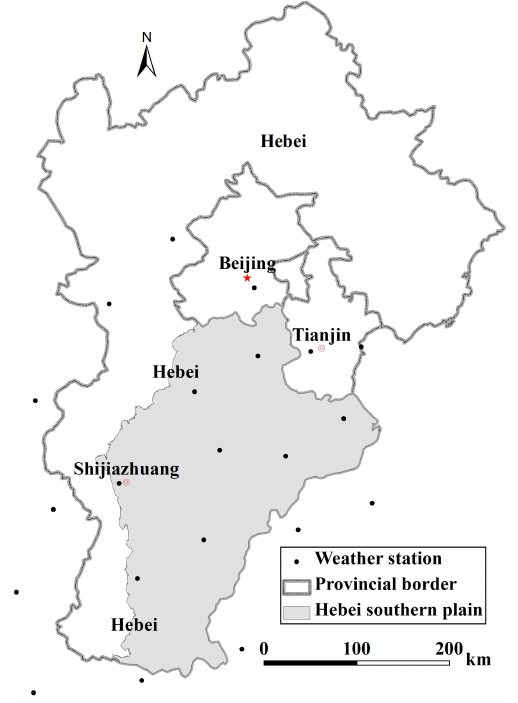
Figure 1. Location of the Hebei southern